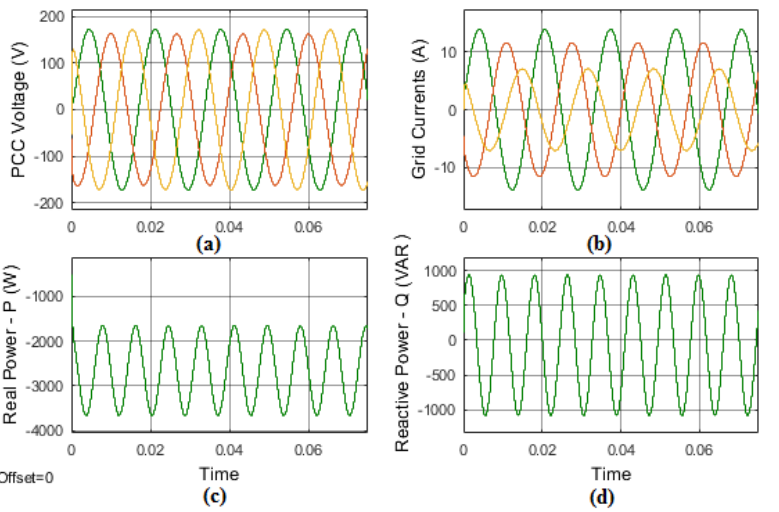
Figure 4. Unbalanced load and unbalanced grid impedance scenario. ( a ) PCC Voltages; ( b ) Grid currents; ( c ) Real Power; ( d ) Reactive